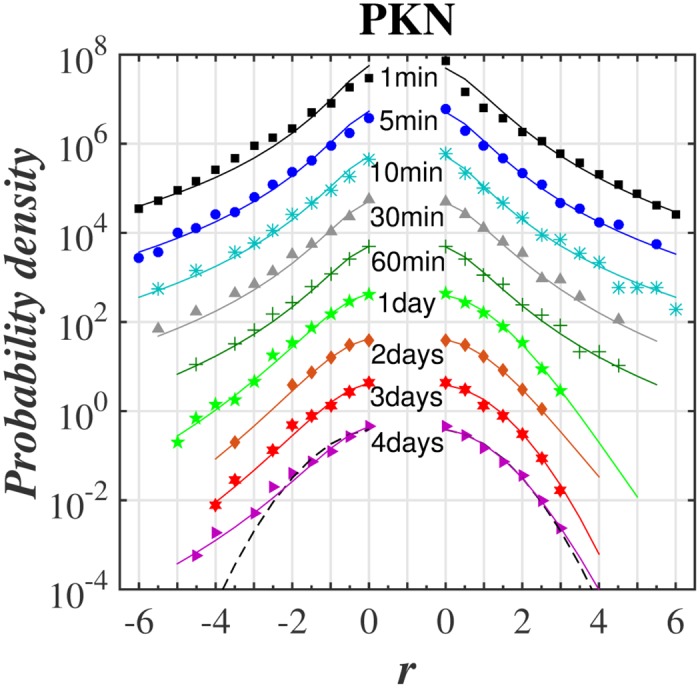
Same as in Fig 1 for PKN orlen stock.